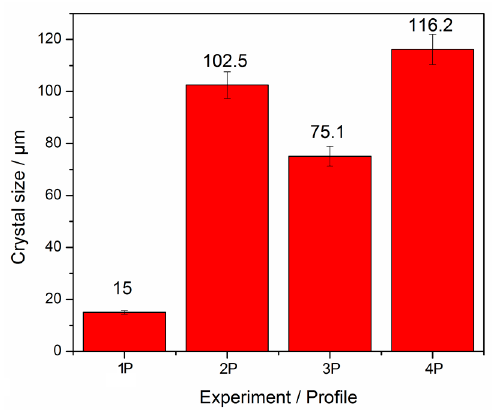
Figure 4. The crystals size is plotted versus type of pulse (which corresponds to type I to IV in the text) on the surface of the electrode, where the smallest number of crystals were observed.